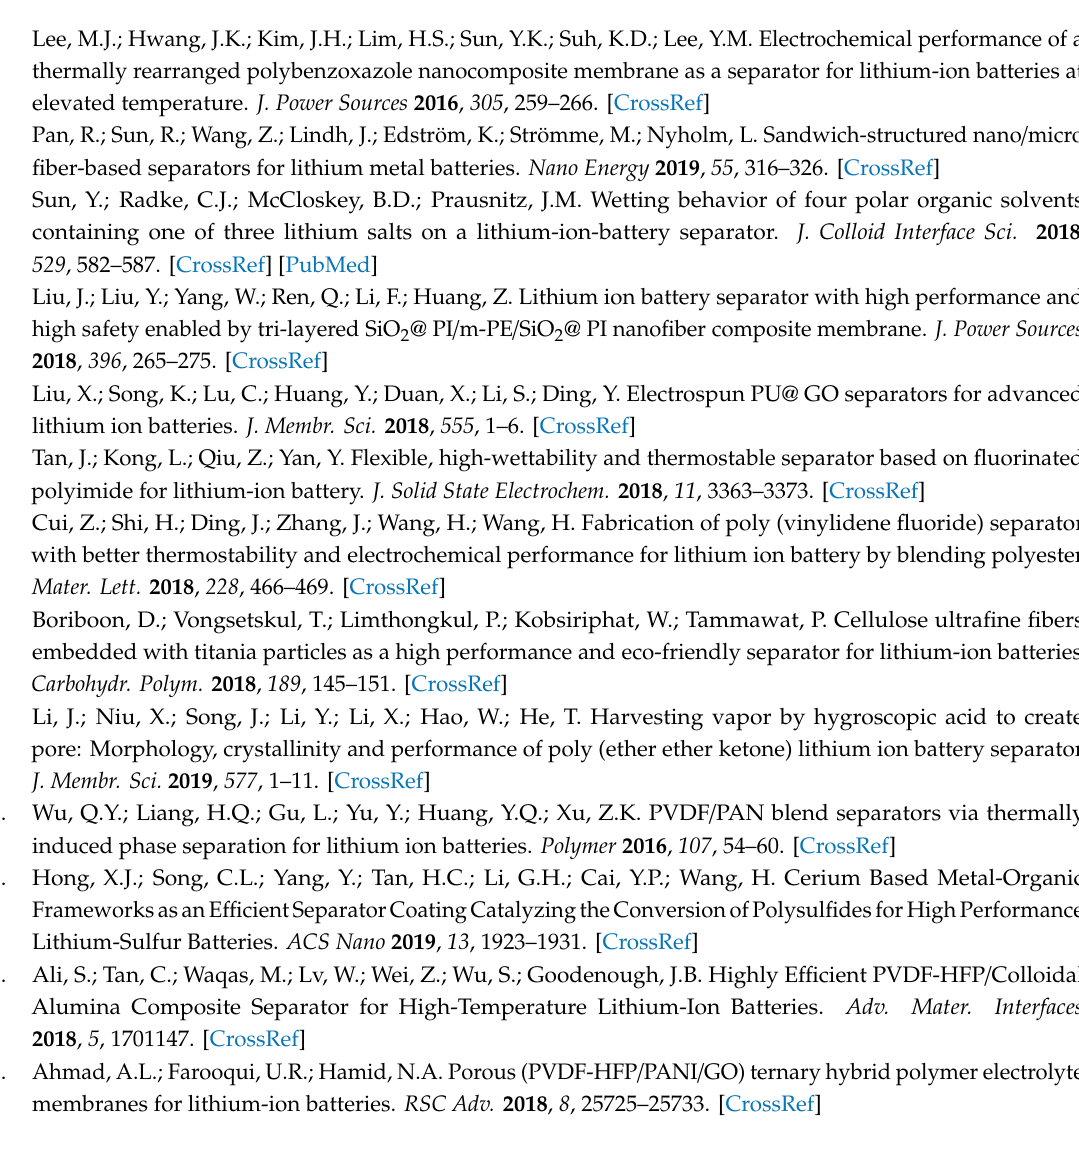
Supplementary Materials: The following are available online at http: // www.mdpi.com / 2073-4360 / 11 / 10 / 1671 / s1, Table S1: Electrolyte uptake of separator with di ff erent materials, Table S2: Electrochemical performance of LIBs with di ff erent separators, Table S3: Battery performance with di ff erent separators. Author Contributions: Conceptualization, W.Y.; Y.L.; Formal analysis, X.H.; J.Y.; Funding acquisition, Y.L.; Investigation, W.Y.; Z.C.; M.H.; W.T.; Methodology, W.Y.; Z.H.; F.L.; Writing—original draft, W.Y.;